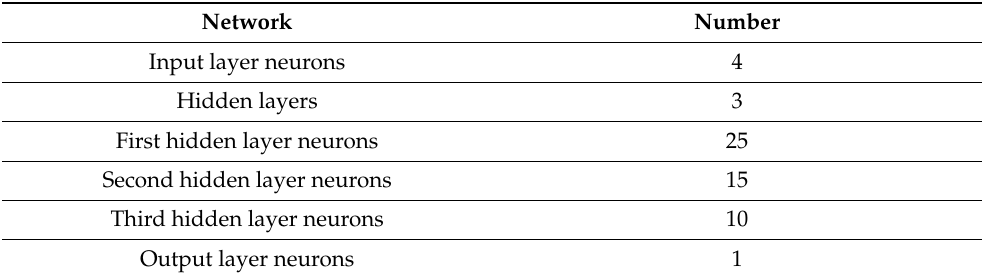
Table 3. Optimized MLP neural network